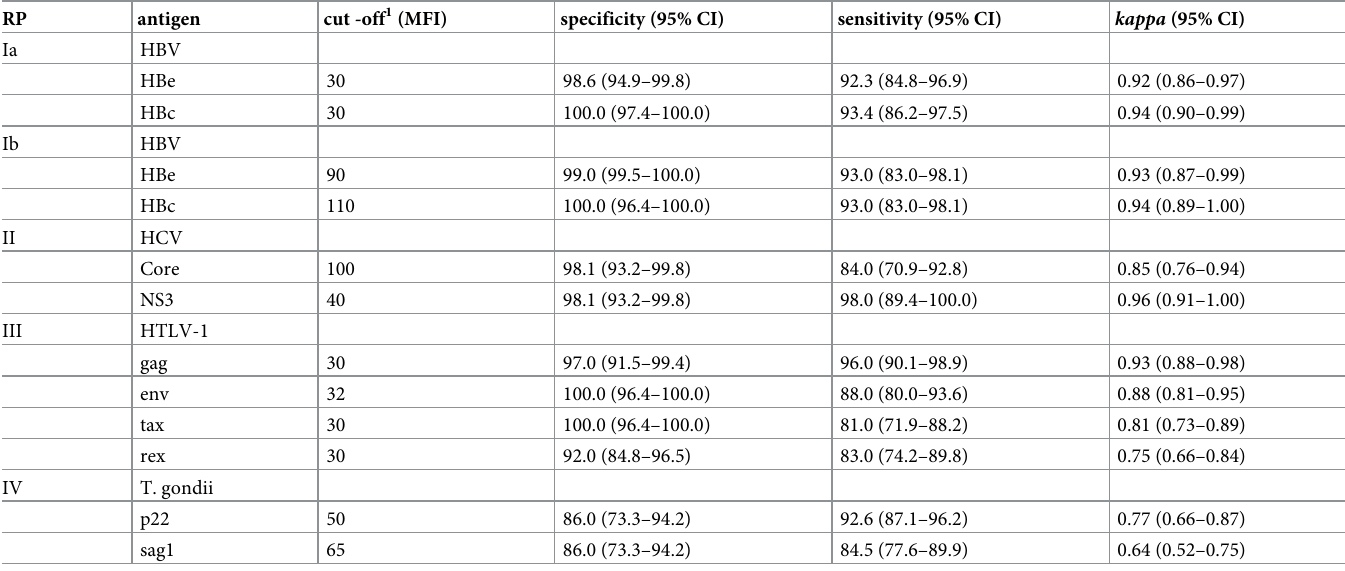
Table 3. Single antigen performance in Monoplex Serology in corresponding reference